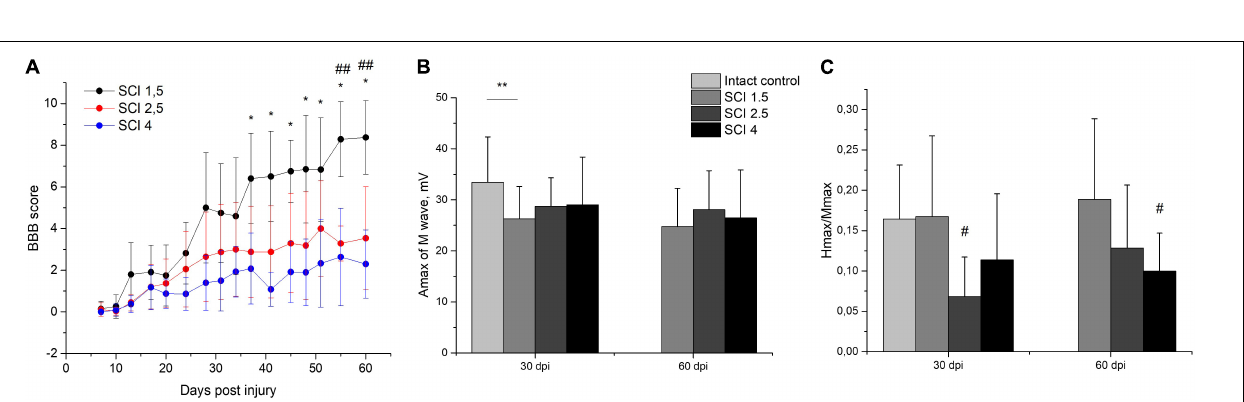
FIGURE 2 | Post-SCI behavioral and electrophysiological studies in experimental groups. Assessment of locomotor activity using the Basso, Beattie, Bresnahan (BBB) rating scale from 7 to 60 days after spinal cord injury of mild (SCI 1.5), moderate (SCI 2.5), and severe (SCI 4) severities (A) , n = 20 in each group. The motor function scores were highest in the SCI 1.5 group compared to SCI 2.5 and SCI 4 groups, starting from 2 wpi. * p < 0.05 as compared with the SCI 4 group; ## p < 0.05 as compared with the SCI 2.5 group, one-way ANOVA followed by a Tukey’s post hoc test. Investigation of sciatic nerve conduction on 30 and 60 dpi was shown by Amax of the M-wave (B) and H/M wave amplitude ratio (C) in experimental groups. At 30 dpi, the amplitude of the M-response in the SCI 1.5 group and the Hmax/Mmax in the SCI 2.5 group was lower compared to the intact controls. At 60 dpi, differences in the Hmax/Mmax were only observed between the SCI 4 group and the intact control. ** p < 0.05; # p < 0.05 as compared with intact control, one-way ANOVA, followed by a Tukey’s post hoc